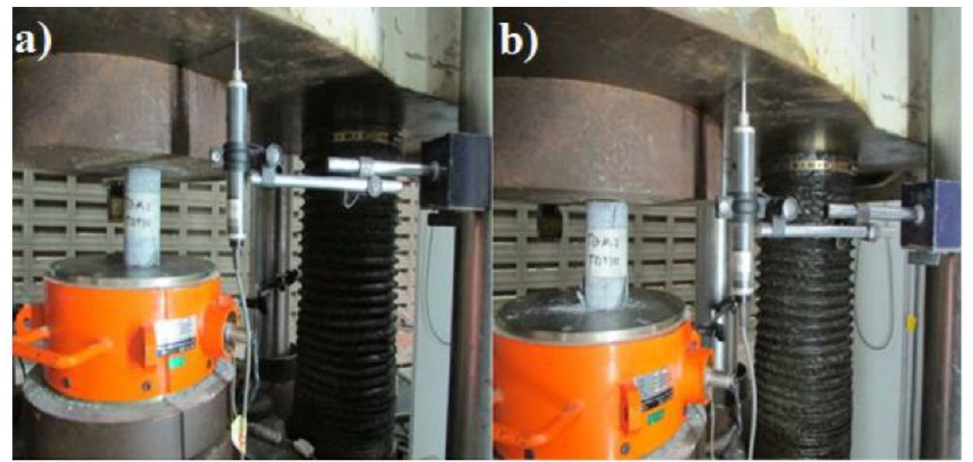
Figure 2. UCS test ( a ) before and ( b ) after failure [3]. Table 1. Descriptive statistics of all variables used in the